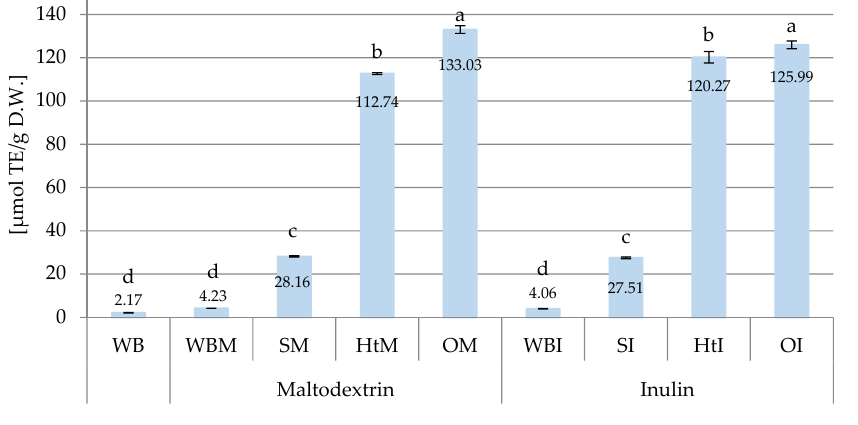
Figure 4 . ABTS antioxidant capacity ( μ mol TE/g D.W.) of different samples of wheat bread. Abbre- Figure 4. ABTS antioxidant capacity ( µ mol TE/g D.W.) of different samples of wheat bread.